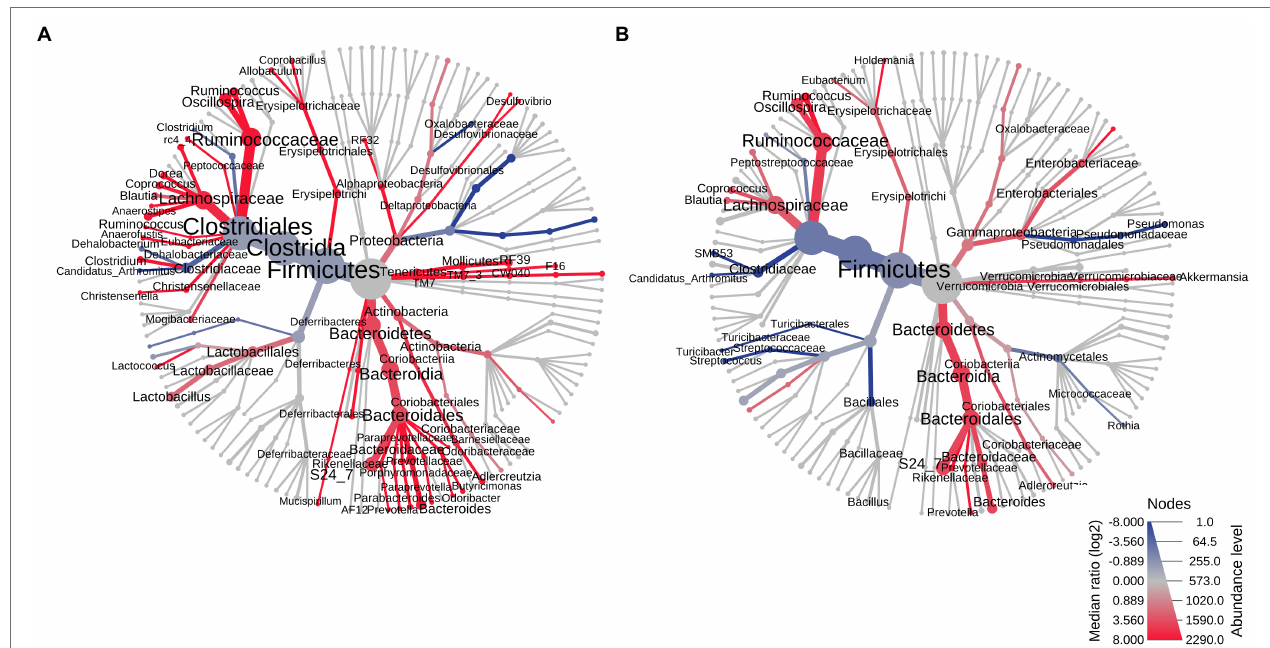
FIGURE 8 | Heat trees of the stool vs. small bowel microbiomes in control and exposed female rats on PAbxD13. (A) Stool vs. small bowel microbiomes in control females. (B) Stool vs. small bowel microbiomes in exposed females. Taxa with lower RA in the small bowel vs. stool are shown in red. Taxa with higher RA in the small bowel vs. stool are shown in blue. Nodes represent taxonomic levels. Greater line thicknesses and greater font sizes denote higher